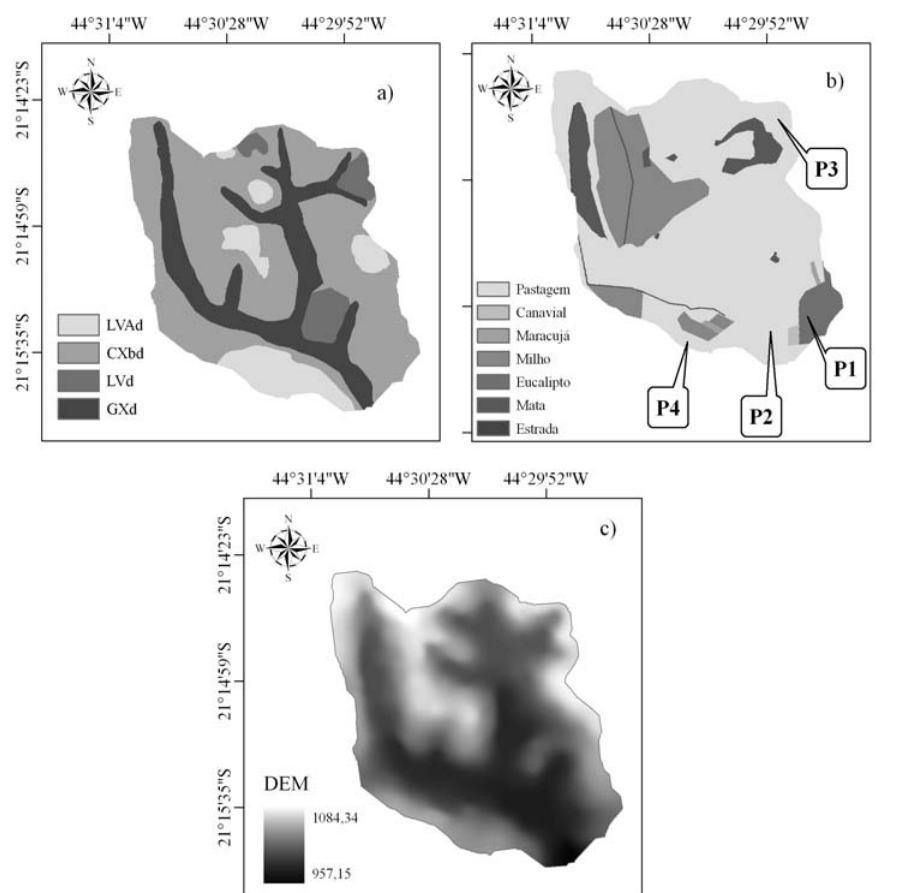
Figura 2. Unidades pedológicas da sub-bacia hidrográfica do Ribeirão Marcela (a), mapa de uso do solo com localização das parcelas de perda de solo (b) e modelo digital de elevação (c).